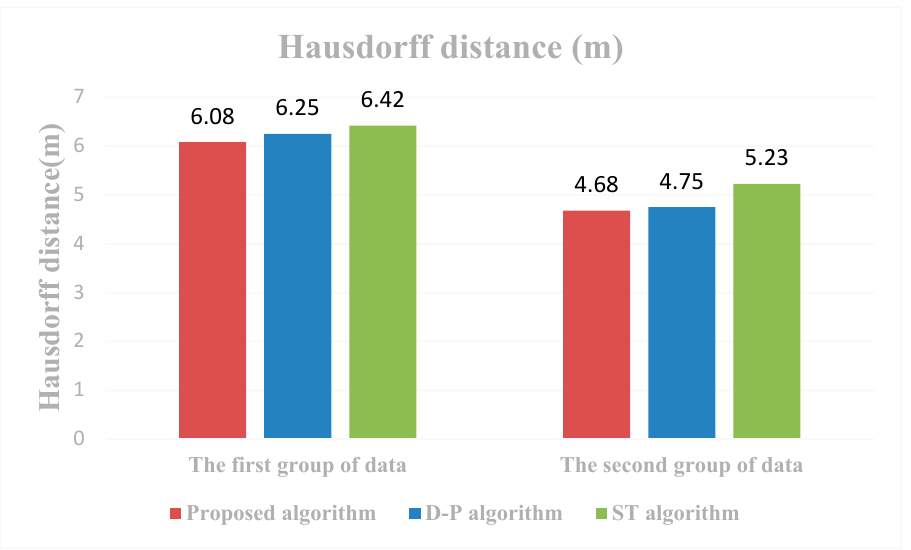
Figure 7. The Hausdorff distance results (m).